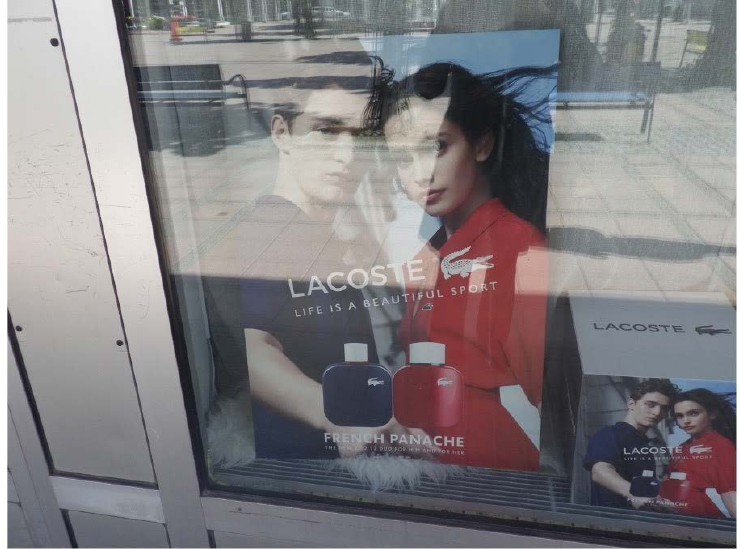
Figure 3. Lacoste Poster in Window .